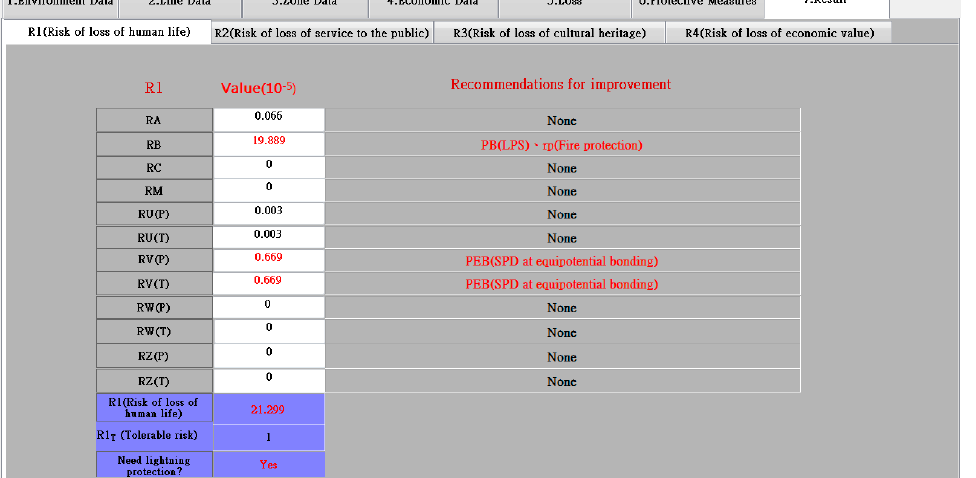
Figure 6. The risk of human life (R1).